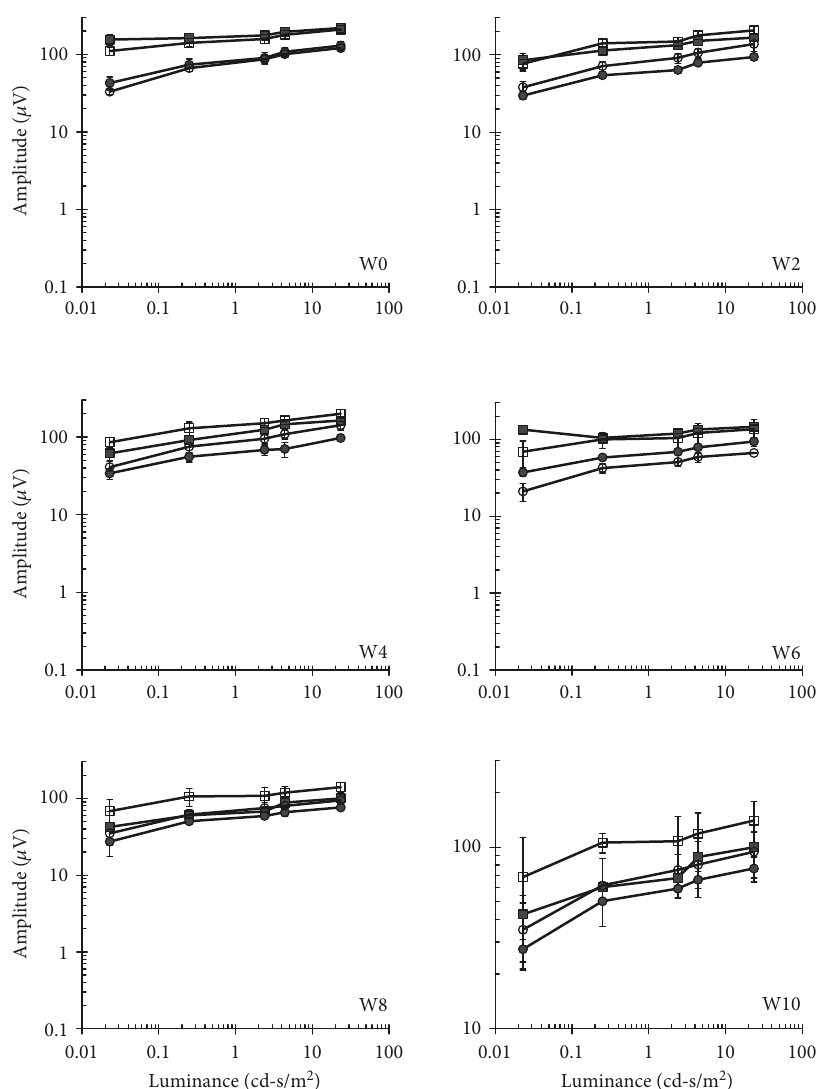
Figure 8: Long-term follow-up of outer retinal function by b-wave ERG analysis. Mean maximal b-wave amplitude ERG responses to light fl ashes in increasing luminance levels were recorded following dark (squares) or light (circle) adaptation, in transplanted (closed) or control (open) eyes at indicated weeks (W) prior to (W0) or 2 – 10 weeks following cell transplantation. Data are presented as mean ±